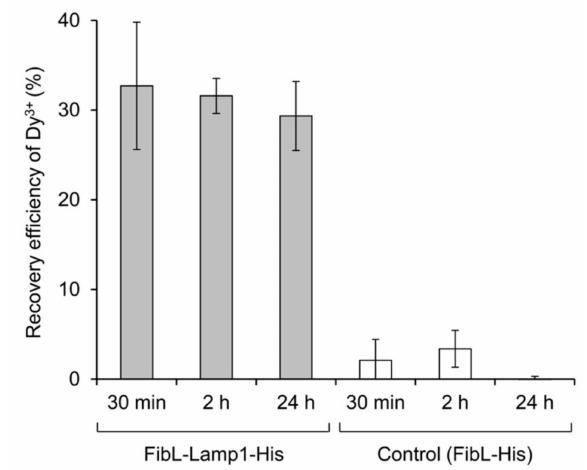
Figure 4. The recovery e ffi ciency of Dy 3 + with the purified protein. The supernatant solution after reaction (mentioned in Figure 2a) was collected, and the Dy 3 + concentration in the solution was determined. Average and standard deviations from three independent experiments were